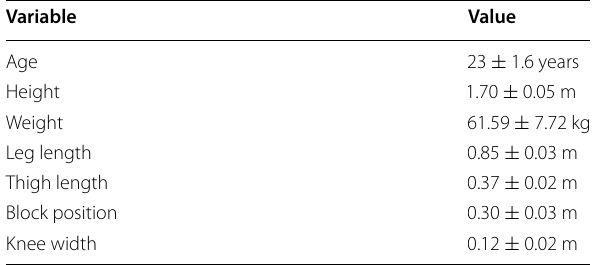
Table 1 Subject measurements ( mean ± sd, n = 7 )